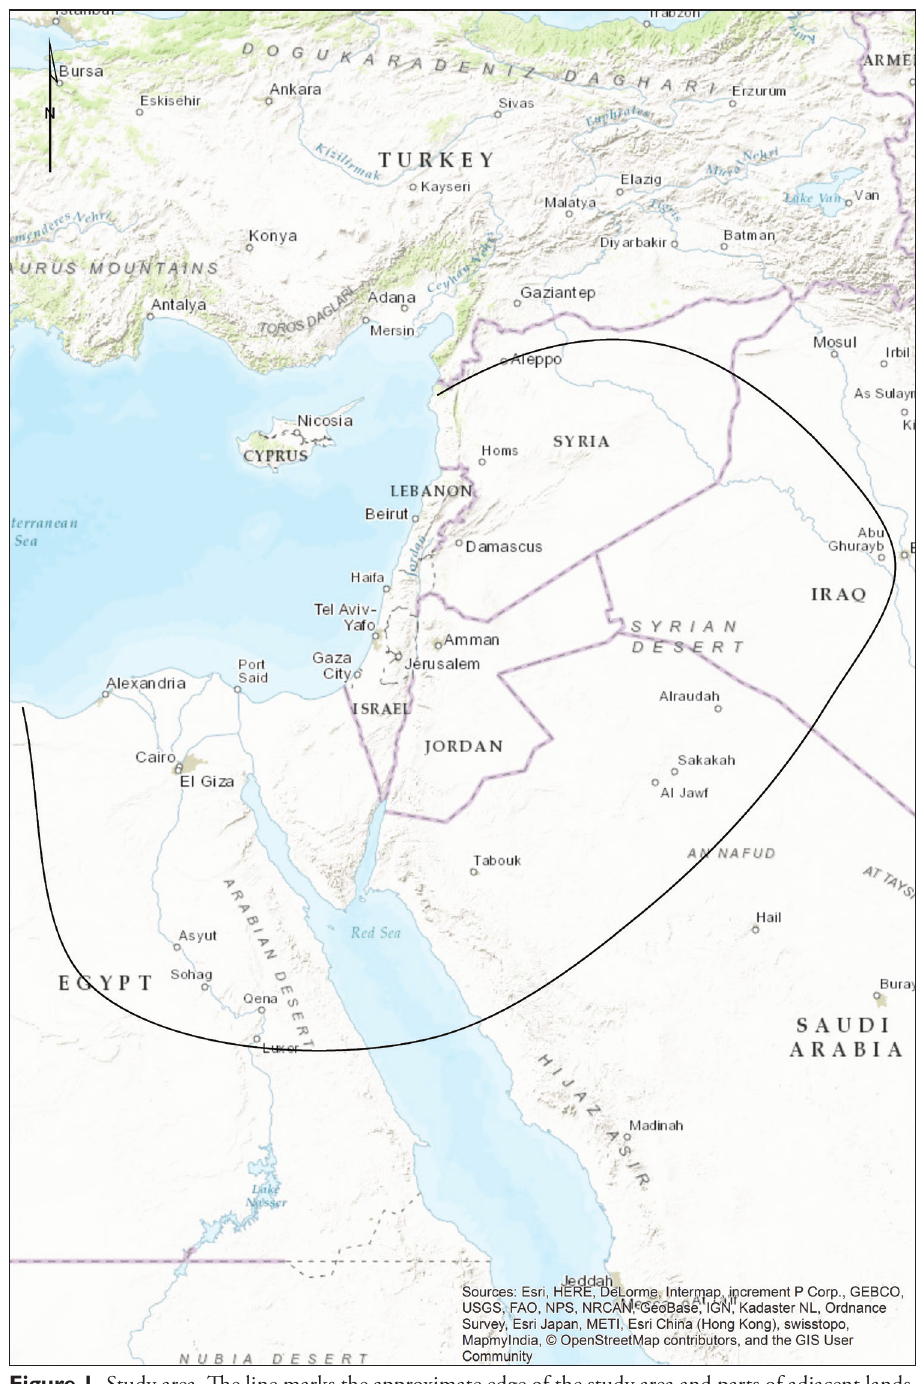
Figure 1. Study area. The line marks the approximate edge of the study area and parts of adjacent lands. Mediterranean islands are